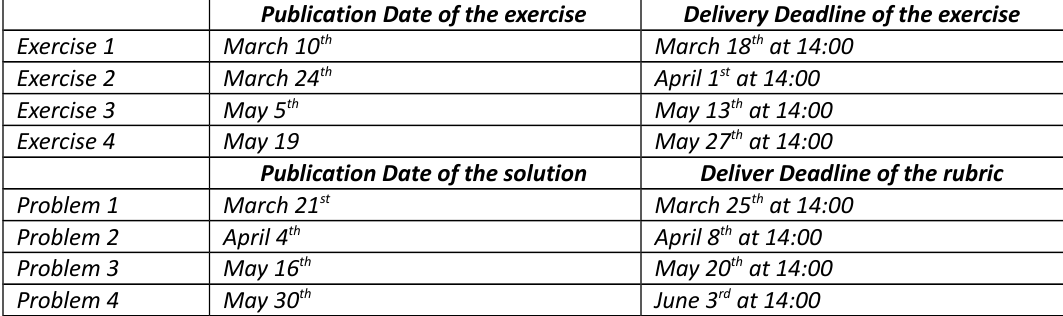
Figure 1. Flow diagram of the autonomous learning activities designed considering the interaction between the teacher and the students. The numbers indicate the order followed Publication Date of the exercise